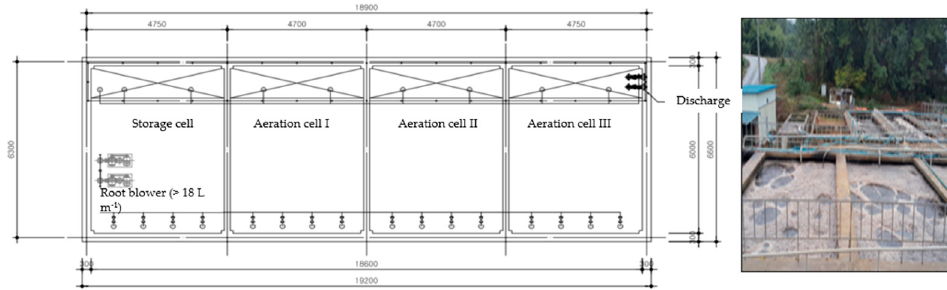
Figure 1. Schematic illustration of typical swine slurry treatment scheme showing storage cell to maturation cell with air blowing unit ( left ) and picture of presently operating PLRC ( right ).